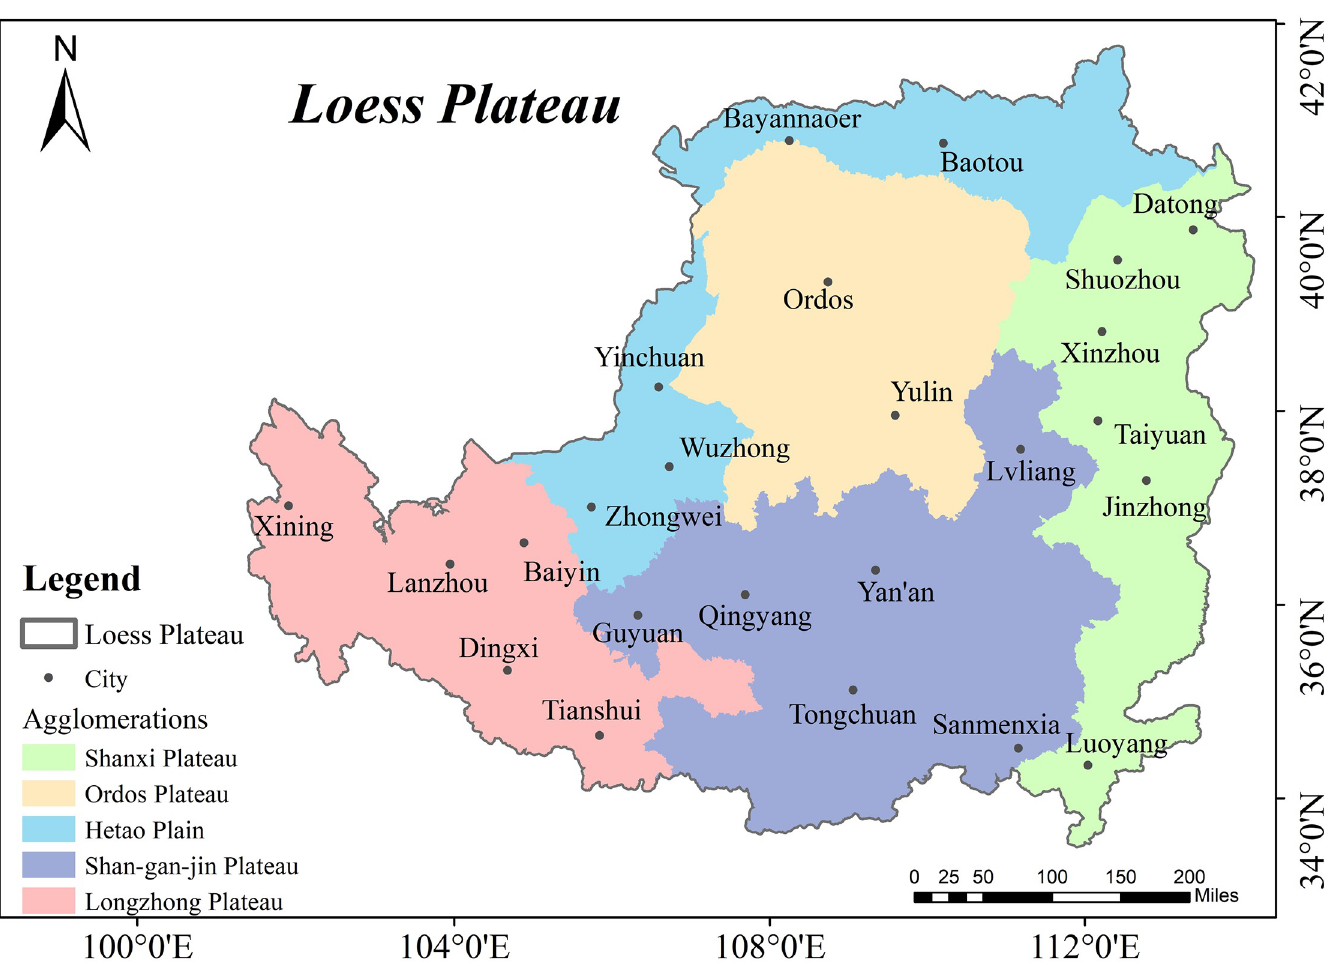
Fig 2. The spatial location of the Loess Plateau region and its representative cities. The base map outline was obtained by using ArcGIS 10.2 based on the Service Center of Standard Map (http://bzdt.ch.mnr.gov.cn/) and the number of the permission is GS (2020) 4621. The spatial extent of the Loess Plateau was obtained from the Resource and Environmental Science Data Center of the Chinese Academy of Sciences